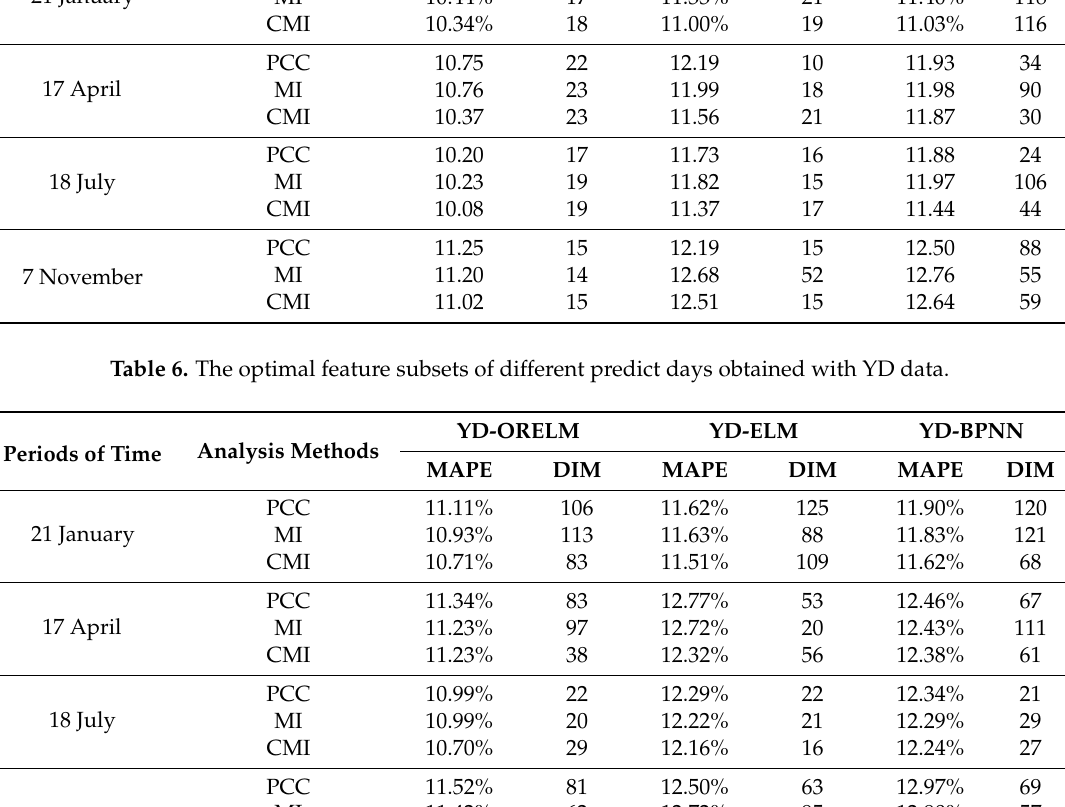
Periods of Time